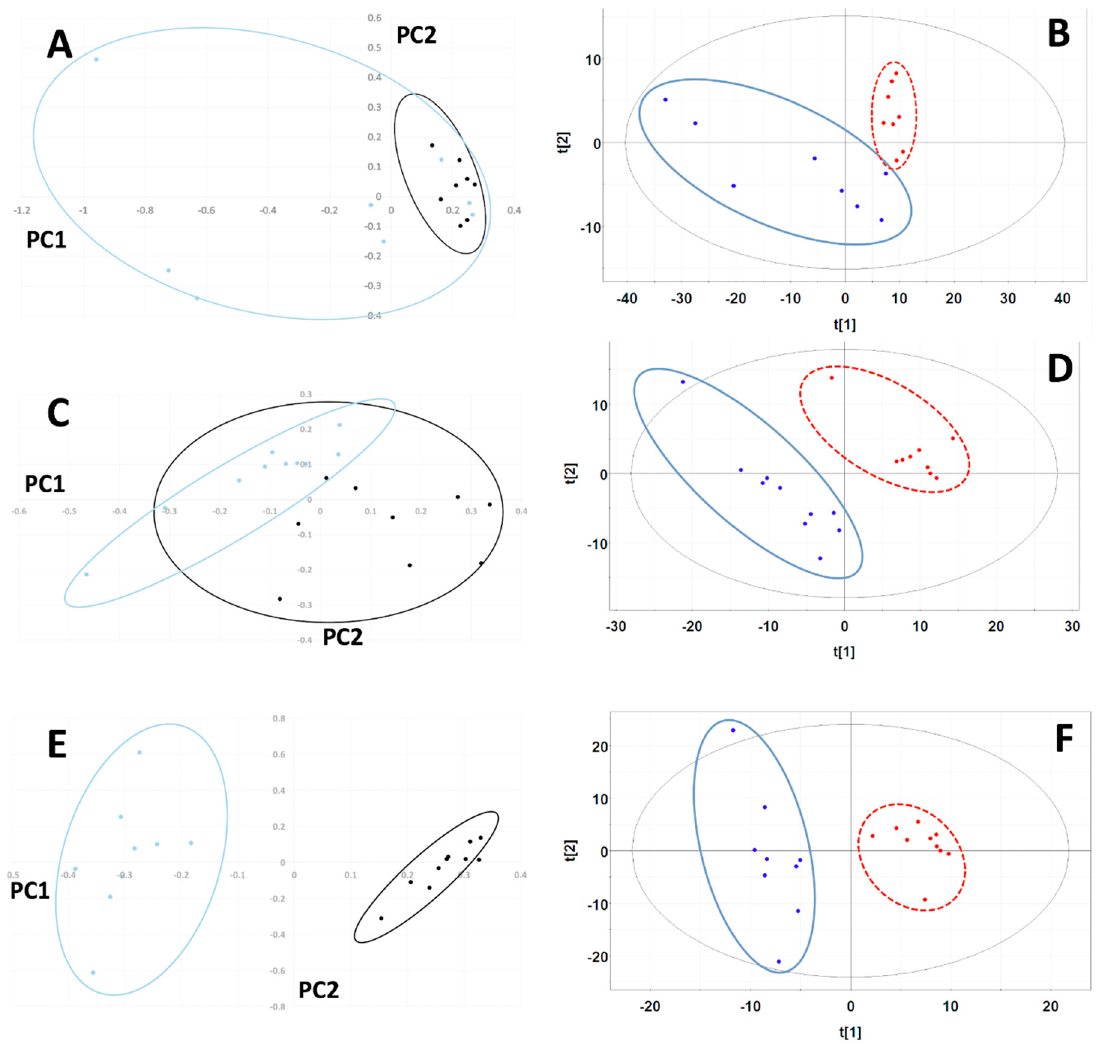
Figure 2. Principal Component Analysis (PCA) and Partial Least Squares-Discriminant Analysis (PLS-DA) scores plots for MiaPaCa-2, Panc-1 and AsPC-1 cell line comparisons. PCA scores plots using the first two principal components for comparisons between lyophilized (blue) and SpeedVac (black) samples from ( A ) MiaPaCa-2, ( C ) Panc-1 and ( E ) AsPC-1 cells. The 95% confidence intervals of the Hotelling’s T 2 distributions are indicated by the overlaid ovals. PLS-DA scores plots computed using the first two principal components for ( B ) MiaPaCa-2, ( D ) Panc-1 and ( F ) AsPC-1 cell comparisons. Scores indicating lyophilized samples are colored blue and encircled by a solid blue oval line. Scores indicating SpeedVac samples are colored red and encircled by a dashed red line. The 95% confidence intervals of the Hotelling’s T 2 distributions are indicated by the overlaid black solid oval lines.